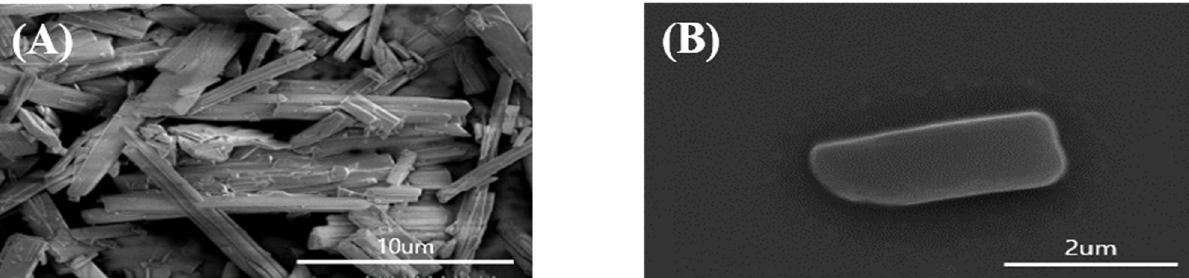
Figure 8. The SEM images of ALH particles from raw ALH ( A ) and dispersion of 2% ALH-loaded Su-SNEDDS (F6) ( B ) in pH 1.2 buffer.